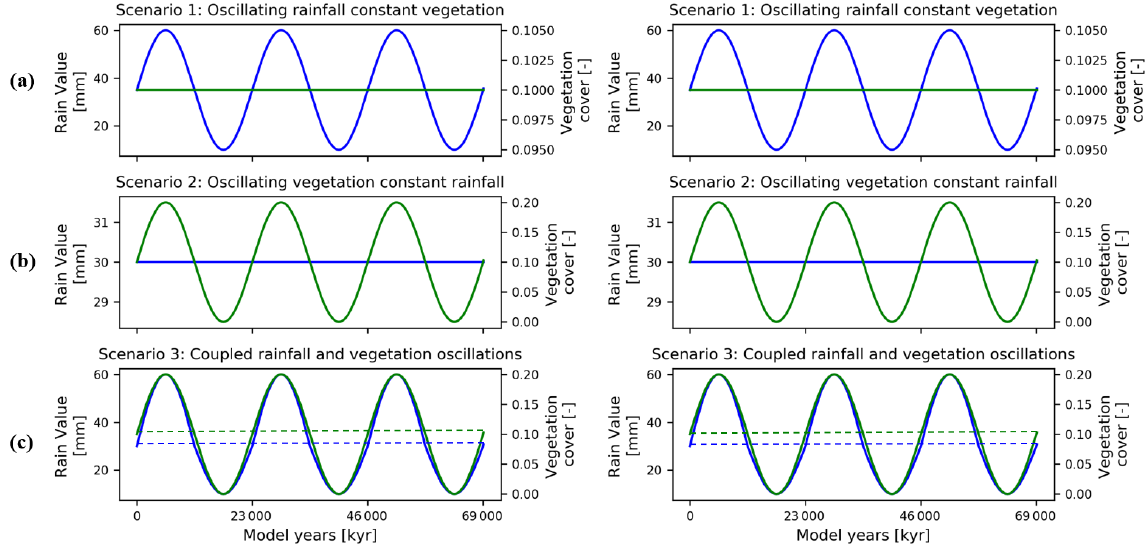
Figure 4. Graphical representation of the different precipitation and vegetation forcings applied to the model scenarios described in the text. Forcings for sparse vegetation (10%) cover are shown on the left and dense vegetation (70%) cover on the right. Scenarios explored include (a) oscillating precipitation and constant vegetation cover, (b) oscillating vegetation and constant precipitation, and (c) coupled oscillations in precipitation and vegetation